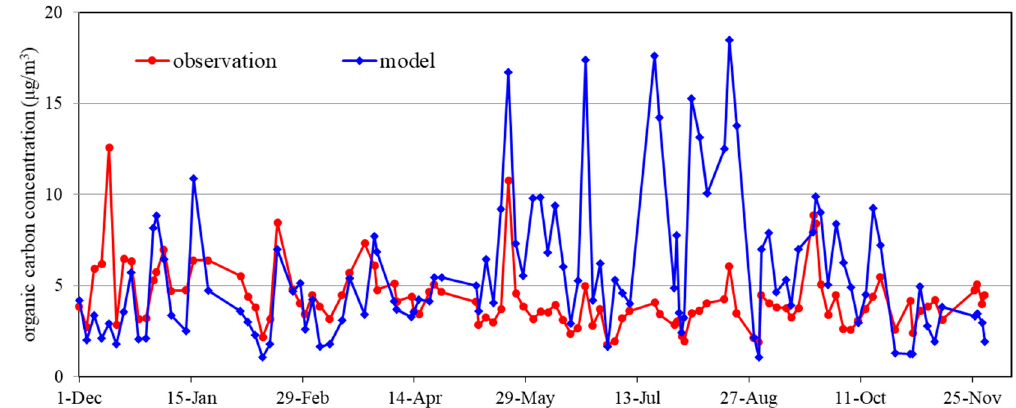
Figure 9. Monthly observed and forecasted organic carbon concentration at the Bulkwang PM supersite.